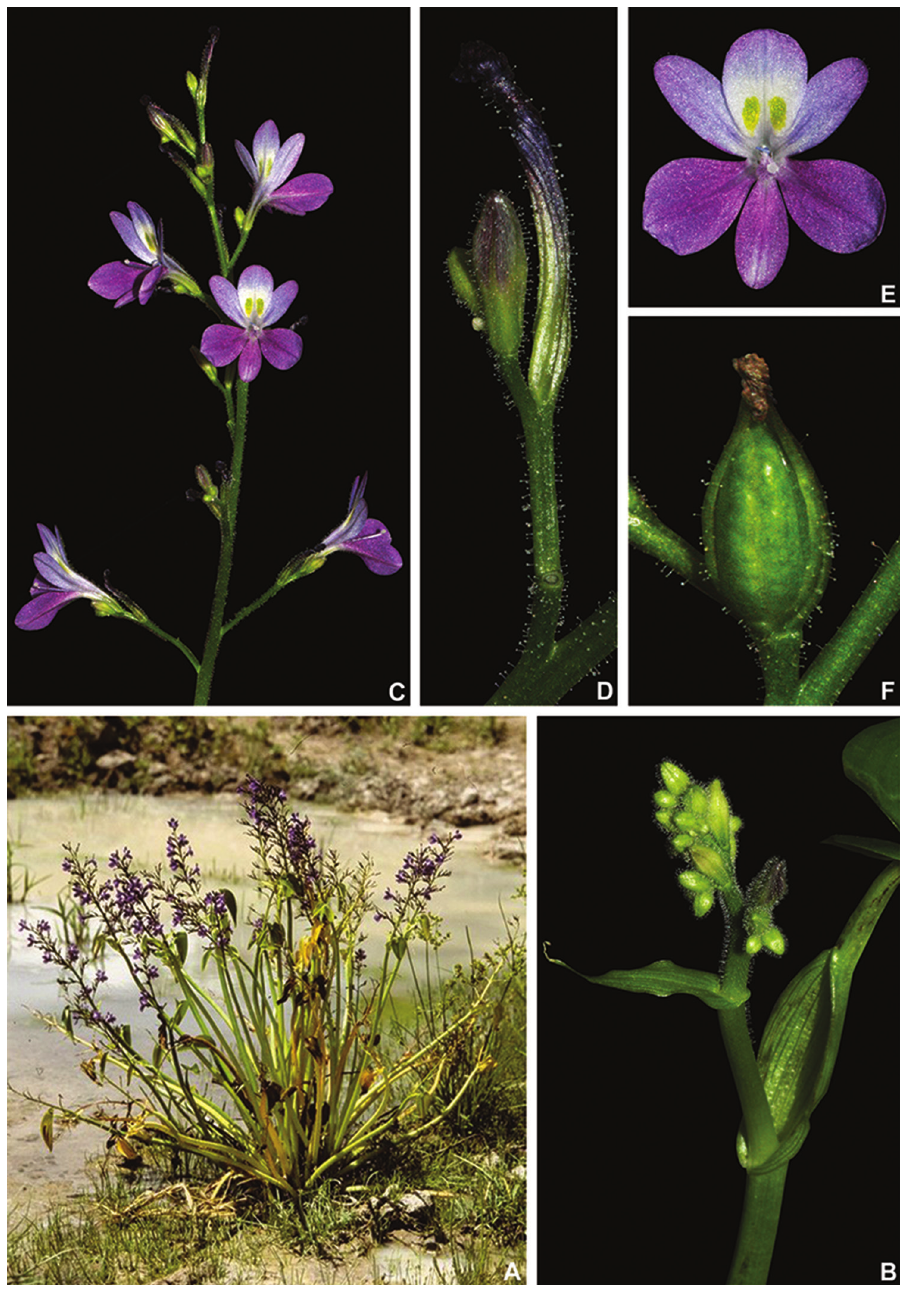
Figure 5. Pontederia subg. Cabanisia (Klotzsch ex Schltdl.) M.Pell. & C.N.Horn. A habit B–C inflo- rescence: B young inflorescence, showing the inflated leaf-sheath and flat basal bract with caudate apex C mature inflorescence showing the pedunculate cincinni with elongate internodes D detail of a cincinni, showing (from left to right) an immature floral bud, a pre-anthesis floral bud and a post-anthesis flower E front view of a flower F detail of an immature capsule, showing the ridged anthocarp. All photos of P. paniculata Spreng.; A by C. Willig & L. Nusbaumer, remaining photos by M.O.O.